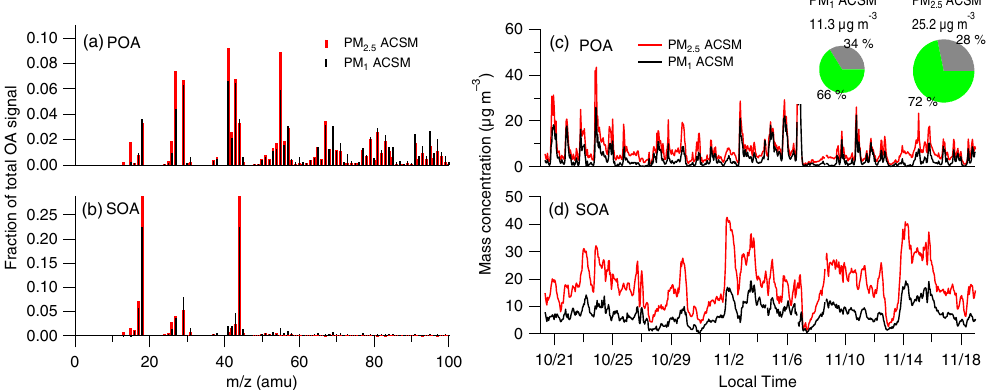
Figure 8. Mass spectra (a, b) and time series (c, d) of POA and SOA for the PM 1 -ACSM and PM 2 . 5 -ACSM, respectively. The average mass concentrations and fractions of POA and SOA were added in the subplots. Dates are indicated in mm/dd format.